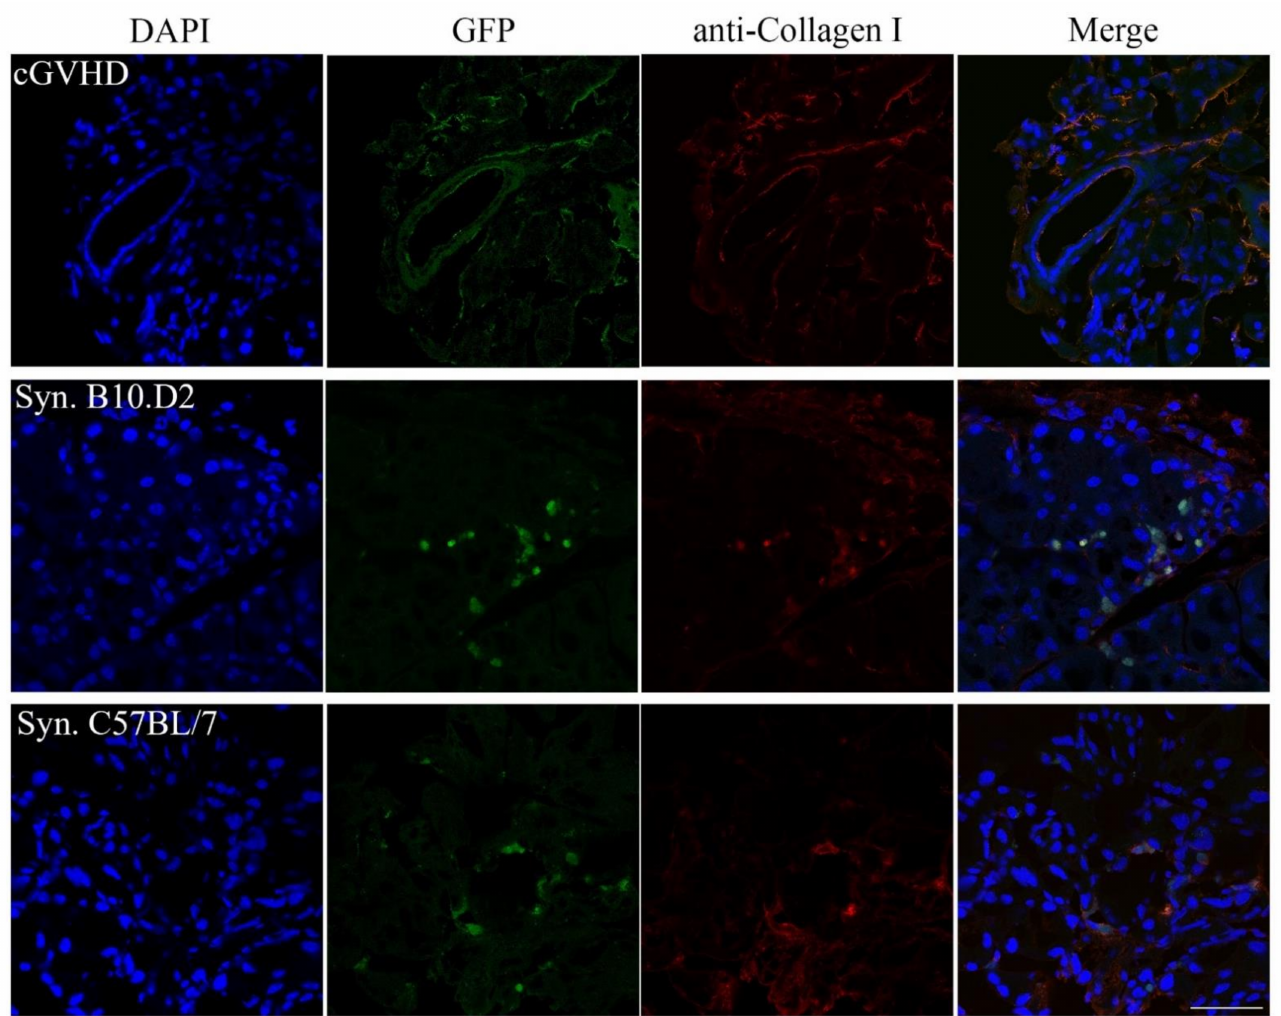
Figure 4. Anti-collagen type I staining in the lacrimal gland of GFP + transplanted mice. Formalin-fixed frozen sections of recipient mice lacrimal glands were stained with an anti-collagen type I antibody. Representative figures from independent experiments (allogeneic n = 9, syngeneic C57BL/6 n = 9, B10.D2 n = 3). The allogeneic recipient (top), as well as both syngeneic models (middle and bottom), were collagen type I positive for most (>85%) of the GFP + cells. DAPI (blue), GFP (green), collagen type I (red), and double-positive cells (yellow).Scale bar = 50 µ m, 400 ×